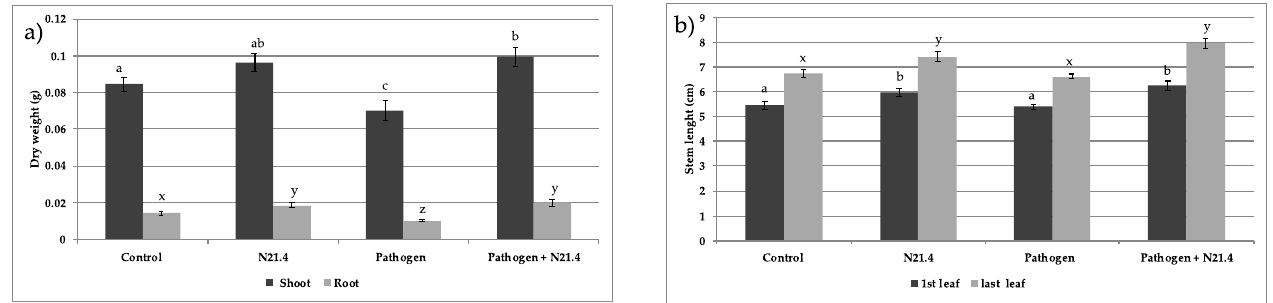
Figure 2. Growth parameters of 6-week old tomato plants inoculated with P. fluorescens N21.4 and non-inoculated controls in the priming phase and in the post-challenged priming state after inoculation with the leaf spot pathogen Xanthomonas campestris . ( a ) Shoot and root dry weight (g). ( b ) Stem length from base to oldest leaf (first leaf) and from base to youngest leaf (last leaf) (cm). Control: Non inoculated or challenged plants. N21.4: plants treated with Pseudomonas fluorescens. Pathogen: plants challenged with the leaf spot pathogen Xanthomonas campestris . Pathogen + N21.4: plants treated with Pseudomonas fluorescens N21.4 and challenged with the leaf spot pathogen Xanthomonas campestris . Bars indicate standard errors ( n = 20). Different letters indicate the existence of significant differences ( p < 0.05) in shoot (a,b,c) and roots (x,y,z) dry weight, or in stem length in the first (a,b,c) or last (x,y,z) leaf.